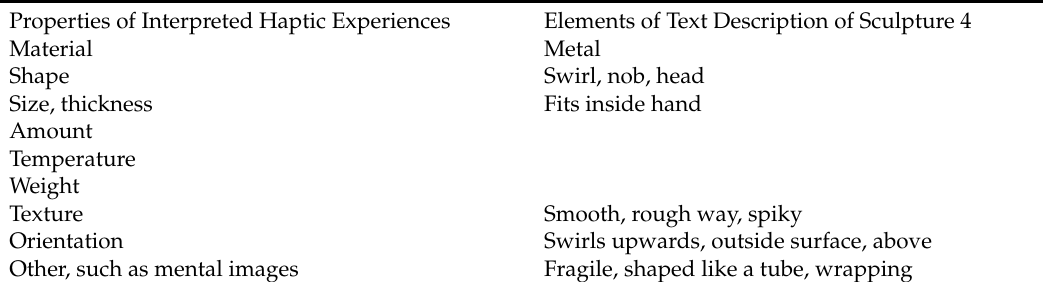
Table 2. Deafblind person’s text of the fourth description according to the developed version of the analytic frame of Akner-Koler and Ranjbar, 2016.